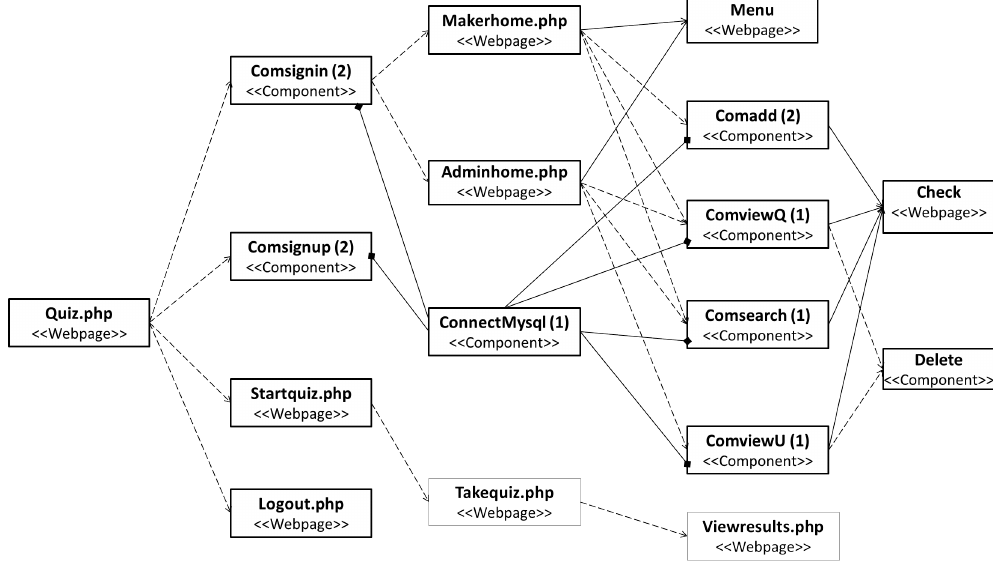
Figure 10. Integrated system